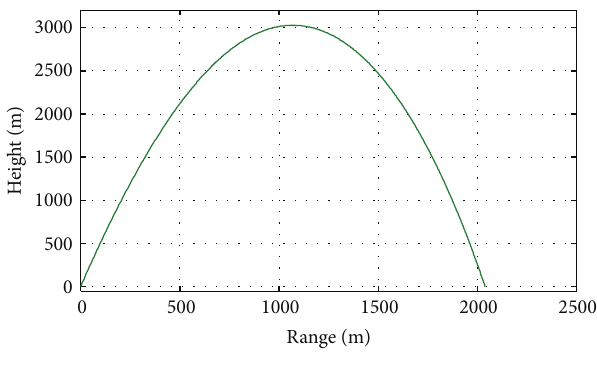
Figure 4: Trajectory